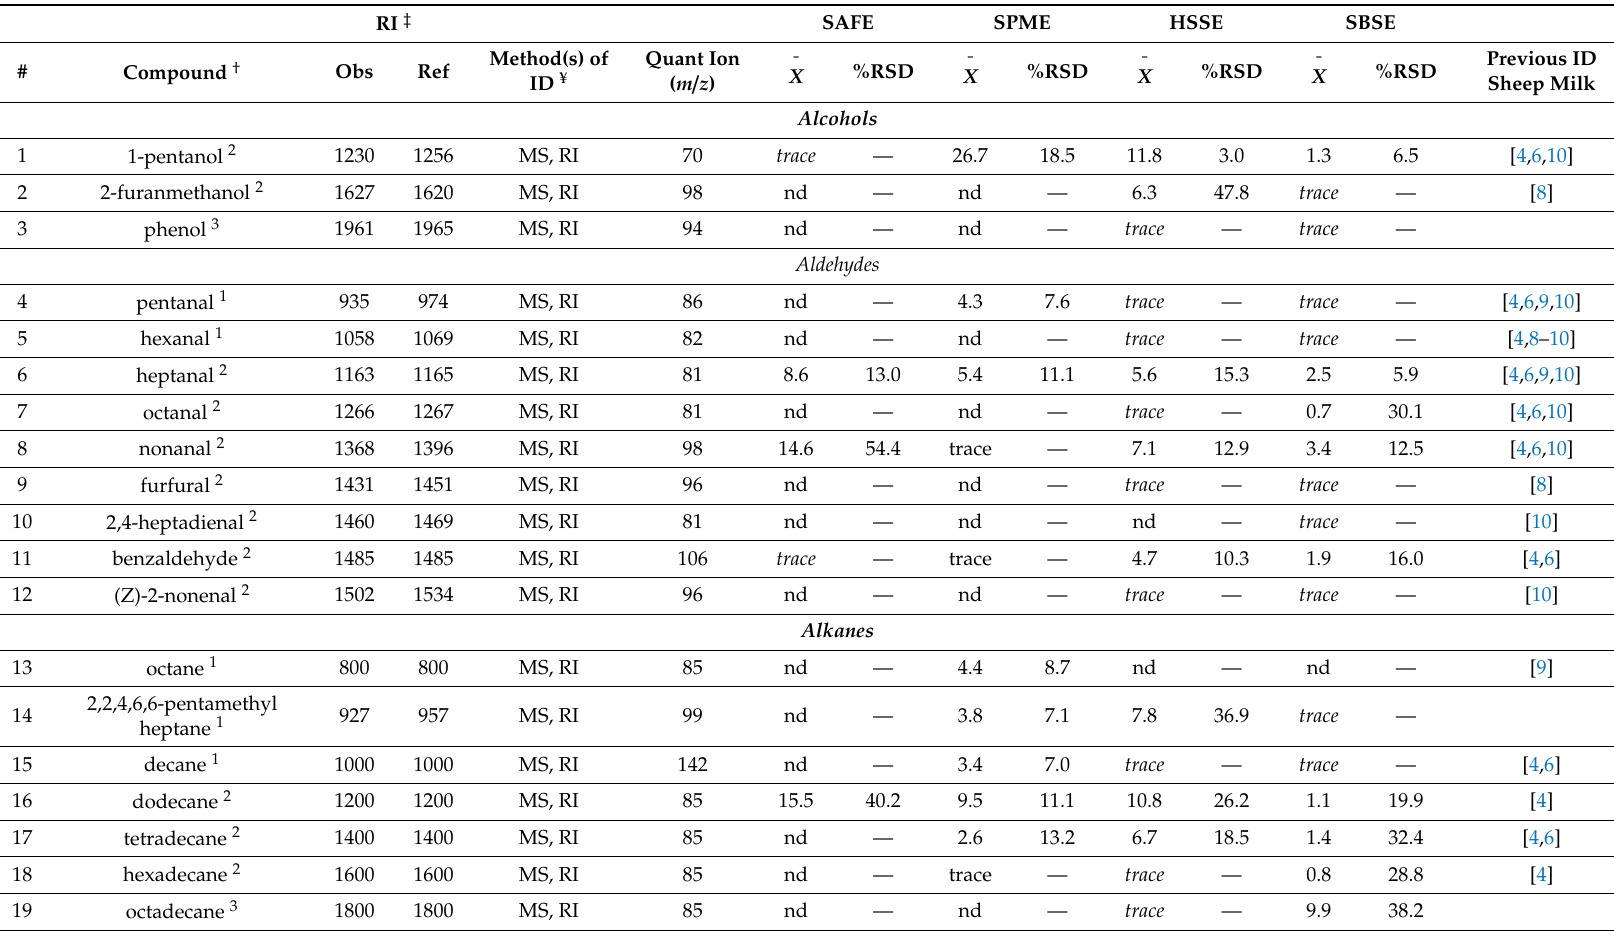
Table 1. Compound identification and apparent concentrations ( µ g / kg) of volatile analytes in spray-dried New Zealand sheep